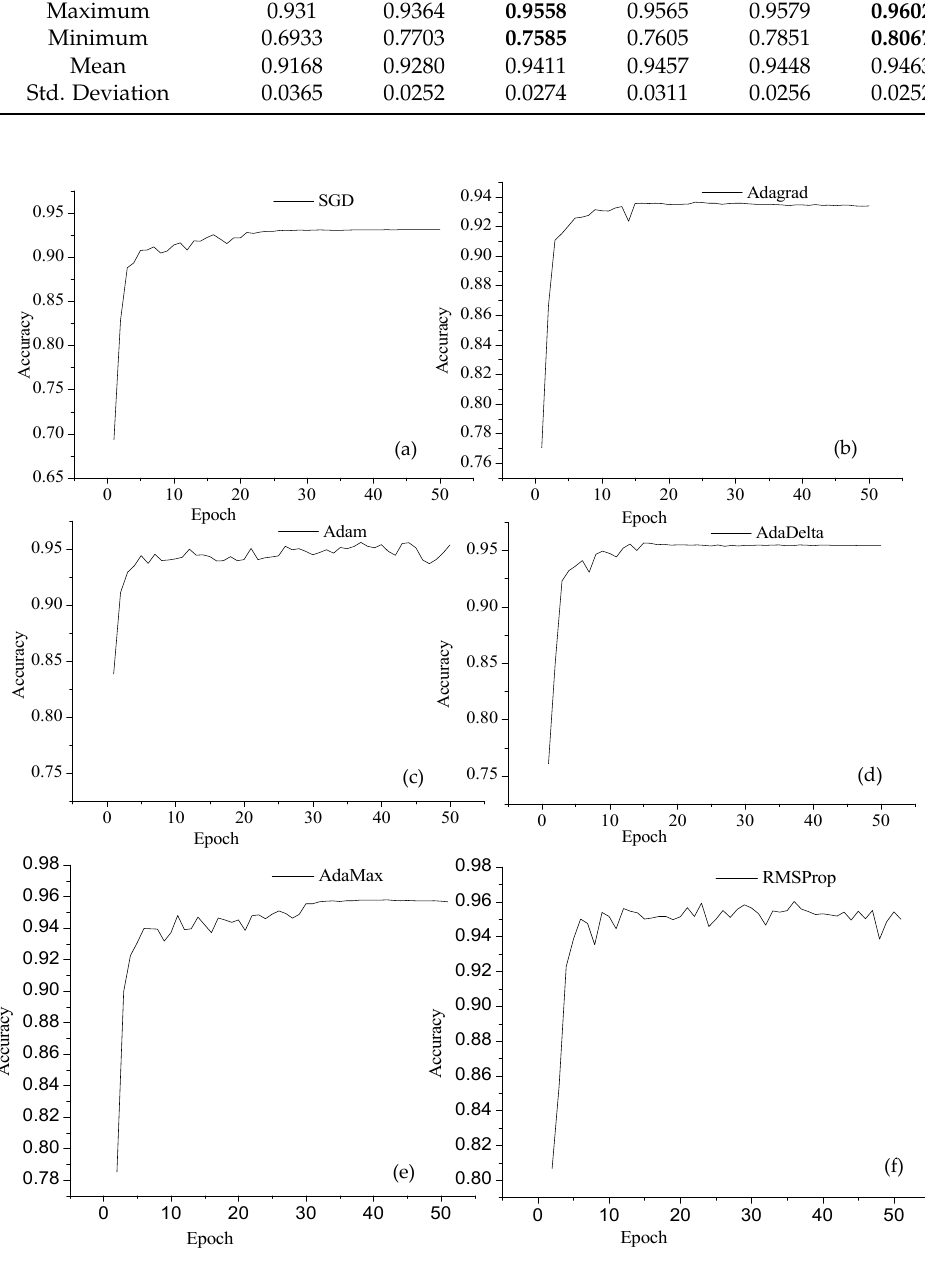
Figure 5. In this figure, we draw the recognition accuracy obtained with NA-6 network architecture at different optimizers ( a ) SGD; ( b ) Adagrad; ( c ) Adam; ( d ) AdaDelta; ( e ) AdaMax; ( f ) RMSProp; on the ISIDCHAR database at each epoch.